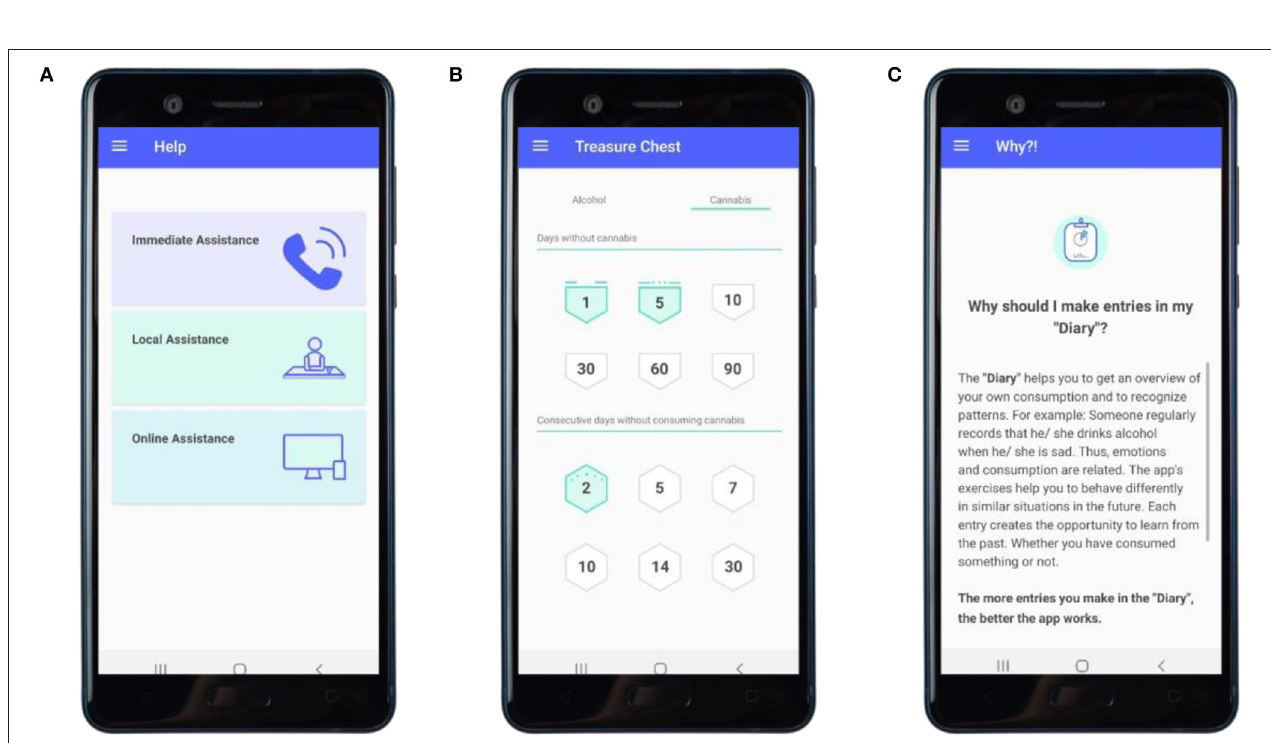
FIGURE 6 | Further modules. (A) Overview of referral pathways offered in the app. (B) Overview of badges acquired. (C) Example of explanatory content on the intervention exercises.